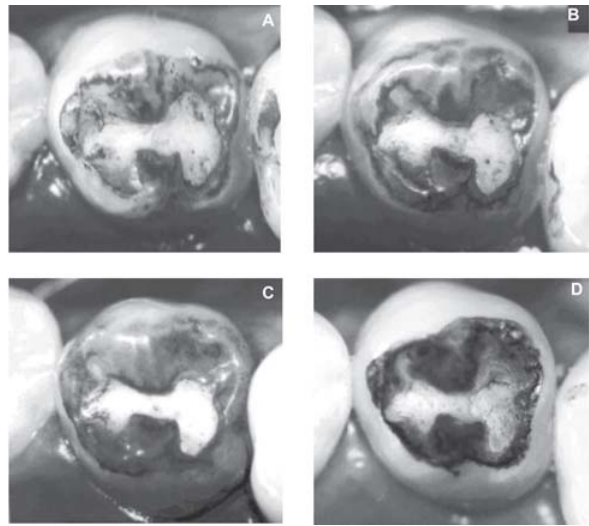
FIGURE 3- Photographs of specimen E38, left maxillary first premolar, presenting occlusal with the Prisma Shield sealant (S2), at the initial period (7 days) (T0) (A), 18 months (T1) (B), 36 months (T2) (C) and 11 years (T3) (D)